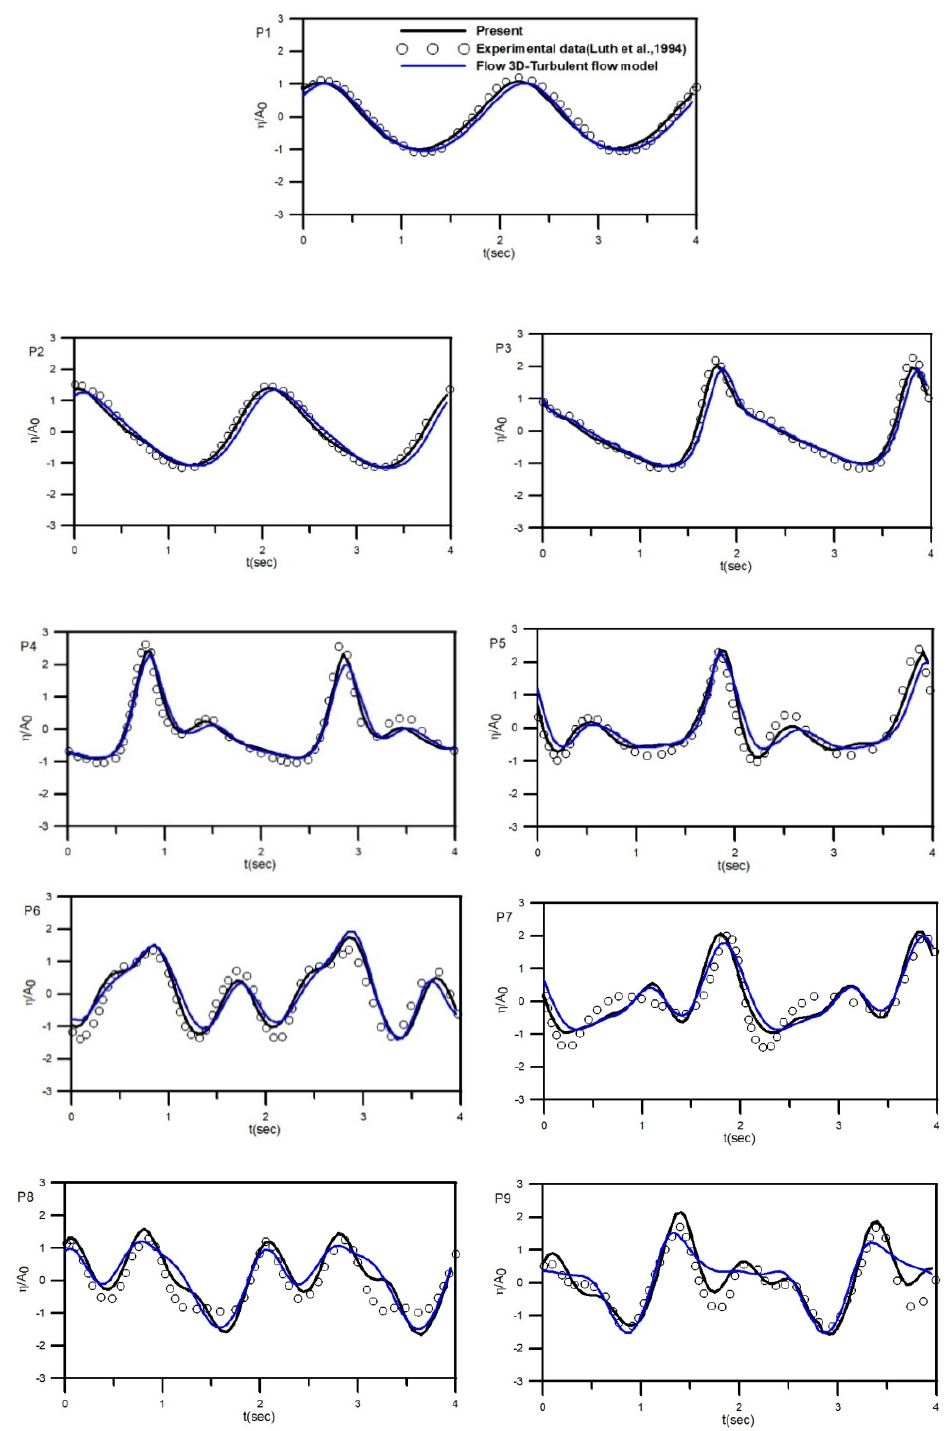
Figure 6. Simulation of surface elevations compared with the experiment at nine wave gauges from